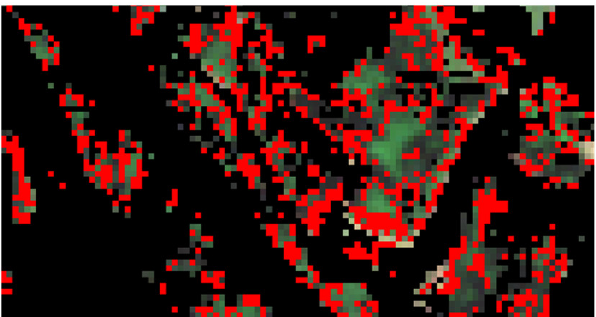
Figure 13. Prediction differences (in red) between RLR-ℓ1 classification map and RF map.